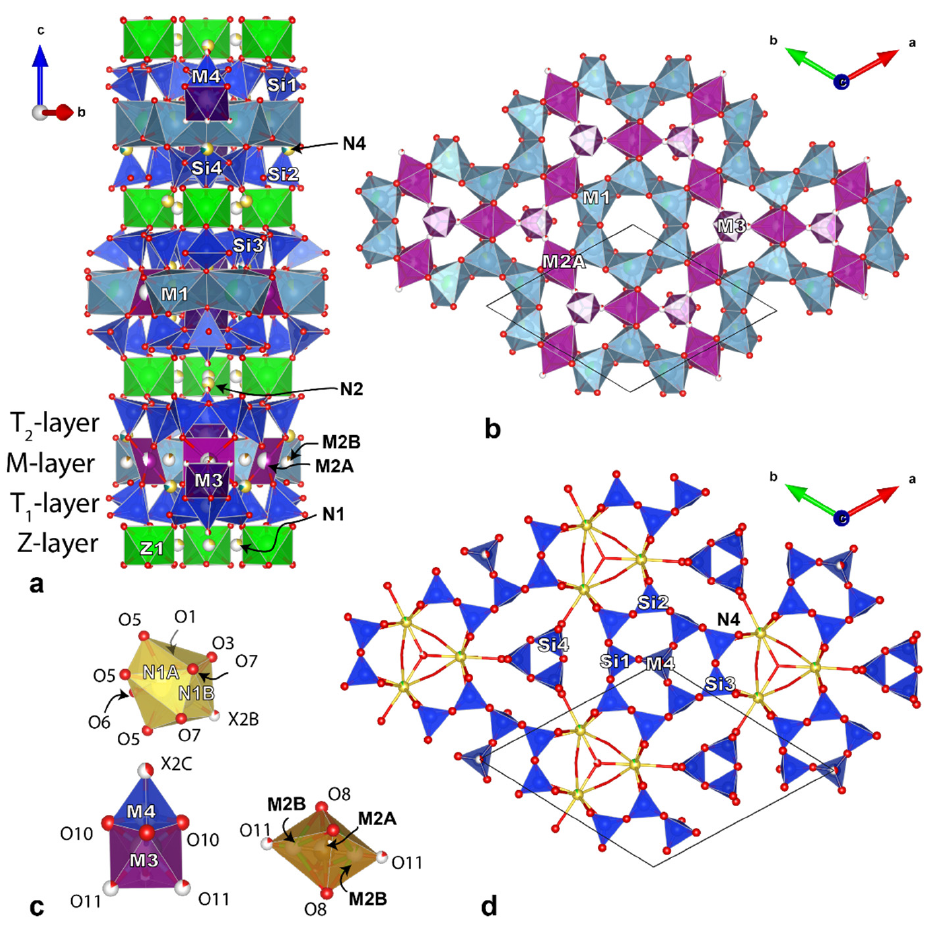
Figure 3. The R 3 m model of the 12-layered ( c ~ 30 Å) EGM crystal structure: ( a ) general view, ( b ) M -layer projected on the plane (001) ( c ) split N1A,B, M 4A,B and M 2A,B sites ( d ) T -layer projected on the plane (001).